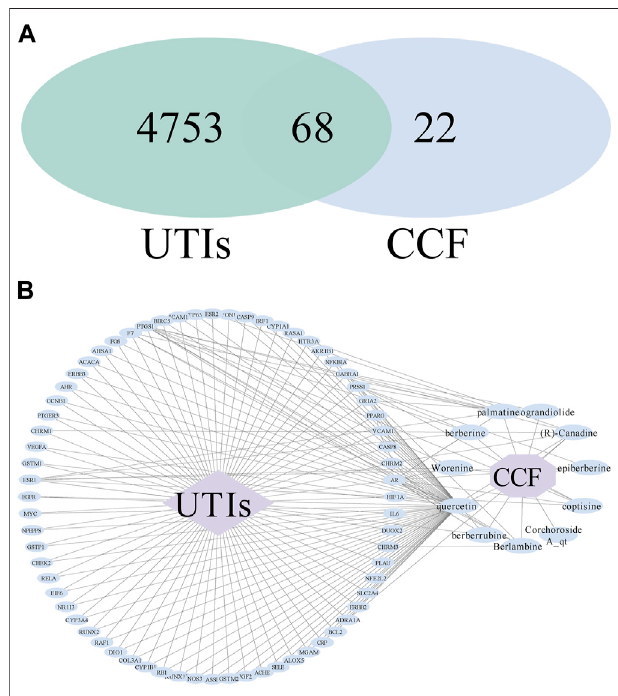
FIGURE 4 | Drug – compounds – genes – disease network. (A) Venn diagram of the drug – disease crossover genes; (B) drug – compounds – genes – disease network. The blue ellipse nodes indicate the targets or ingredients, the purple diamond indicates the disease, the purple octagon means the drug, and the black line represents the